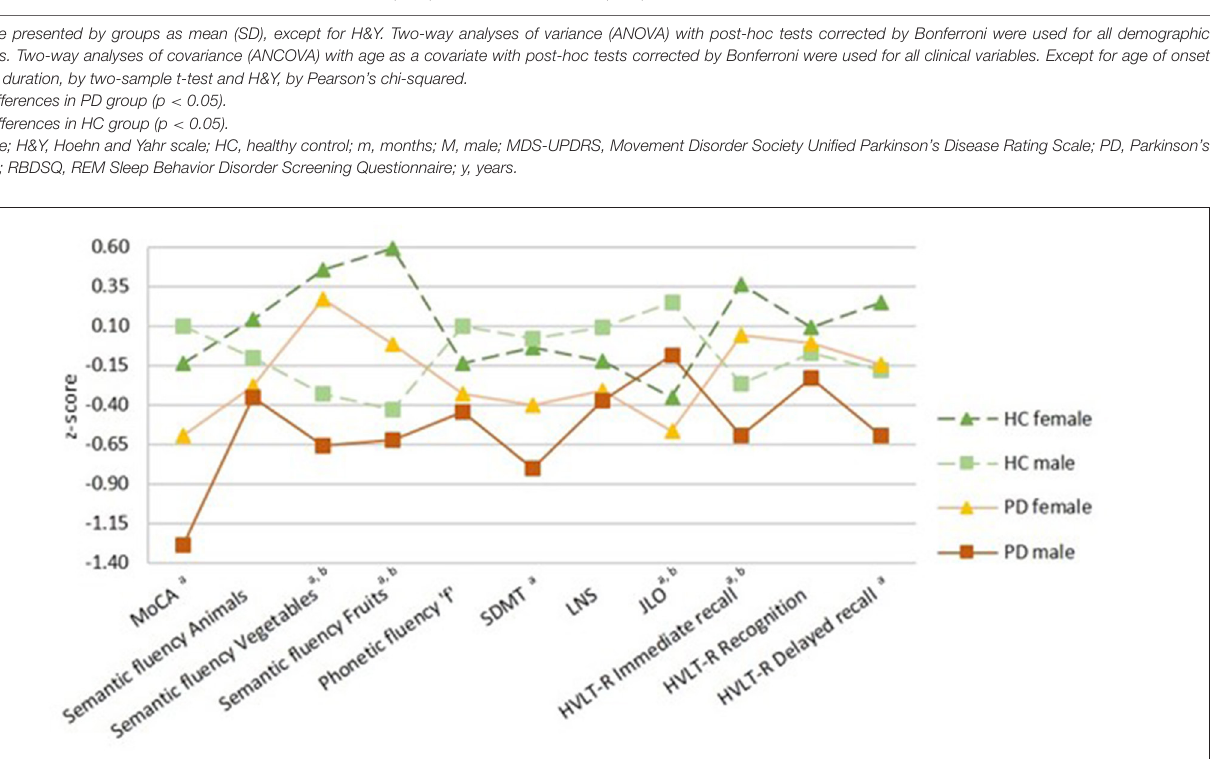
We found cortical thinning in de novo PD males compared with de novo PD females in the left postcentral and right precentral areas. A previous study including treated PD patients